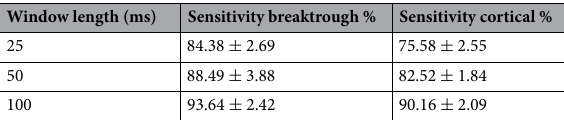
Table 1. Comparison of window length.